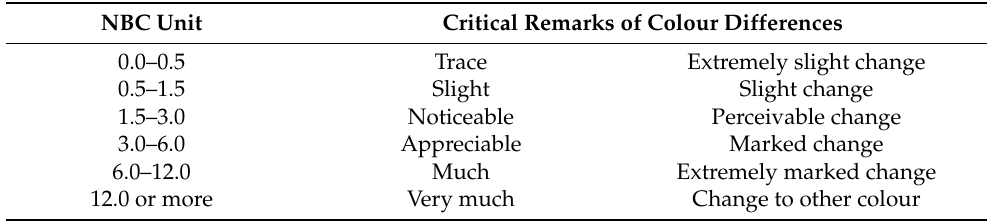
Table 3. National Bureau of Standards (NBS) ratings.